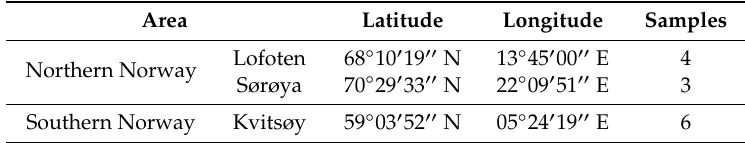
Table 1. Summary of the main features of the study